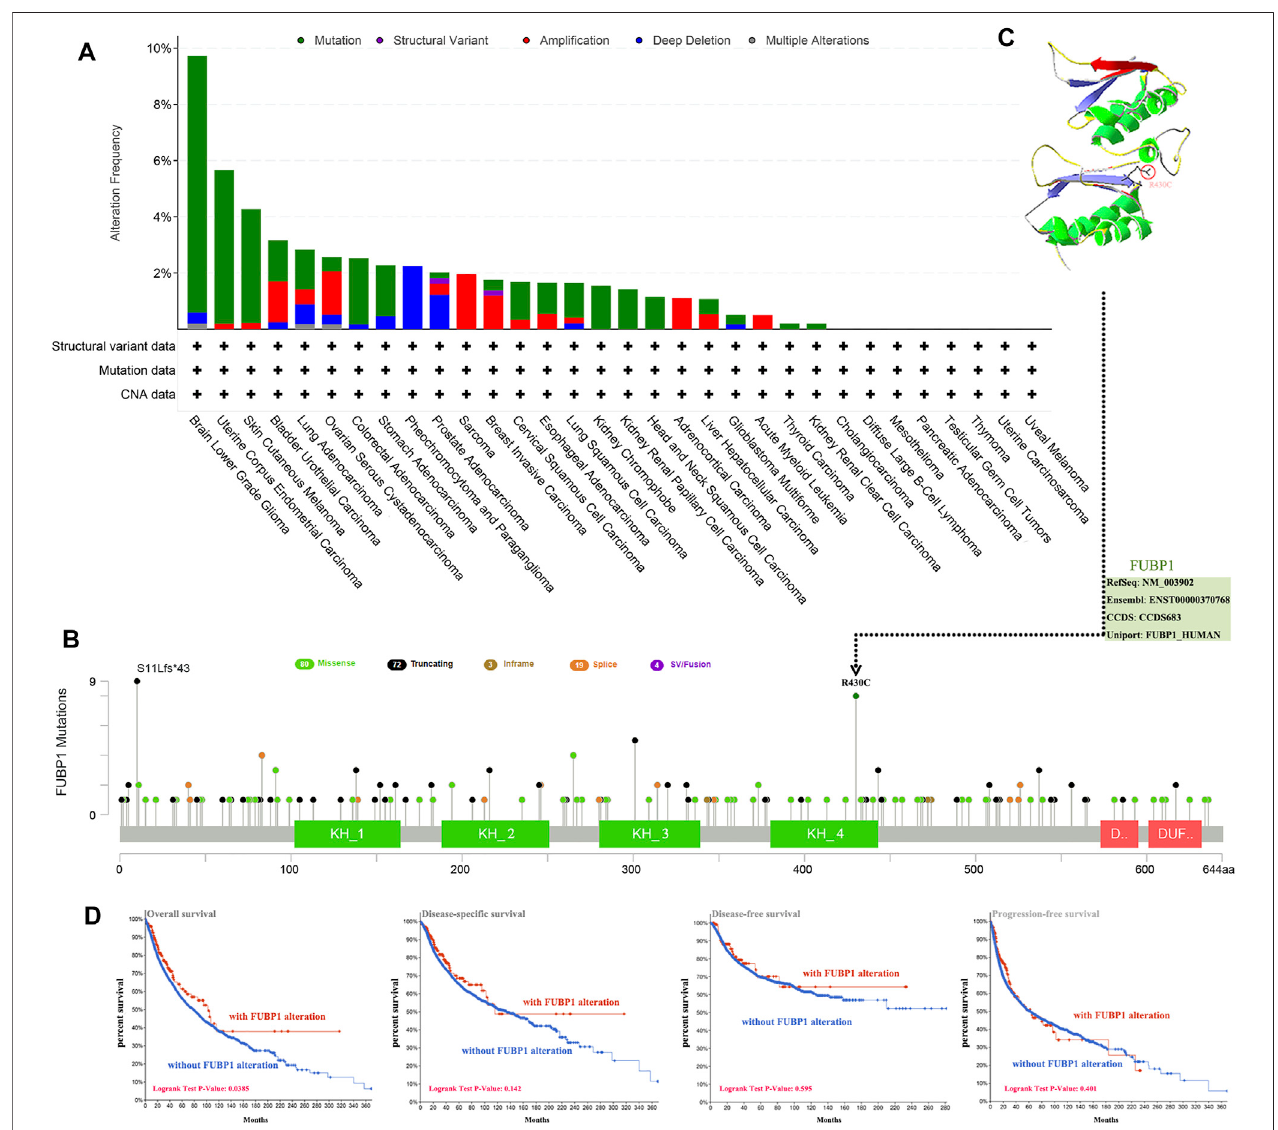
FIGURE 3 | Mutation features of FUBP1 in different cancer types in TCGA. (A) cBioPortal was used to analyze the genetic alterations of FUBP1. (B) The alteration frequency and type as well as the speci fi c sites with the highest alteration frequency (R430C) are displayed. (C) The 3-D structure of the FUBP1 protein was acquired using the SWISS-MODEL tool and Swiss-PdbViewer software. (D) Correlations between FUBP1 mutation and overall survival, disease-speci fi c survival, disease-free survival and progression-free survival in pan-cancer were analyzed using the cBioPortal tool.